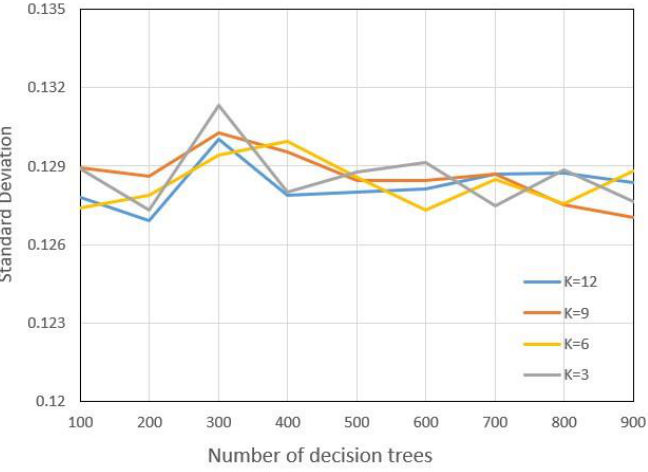
Figure 7. Standard Deviation maps of random forest algorithm under different parameters.